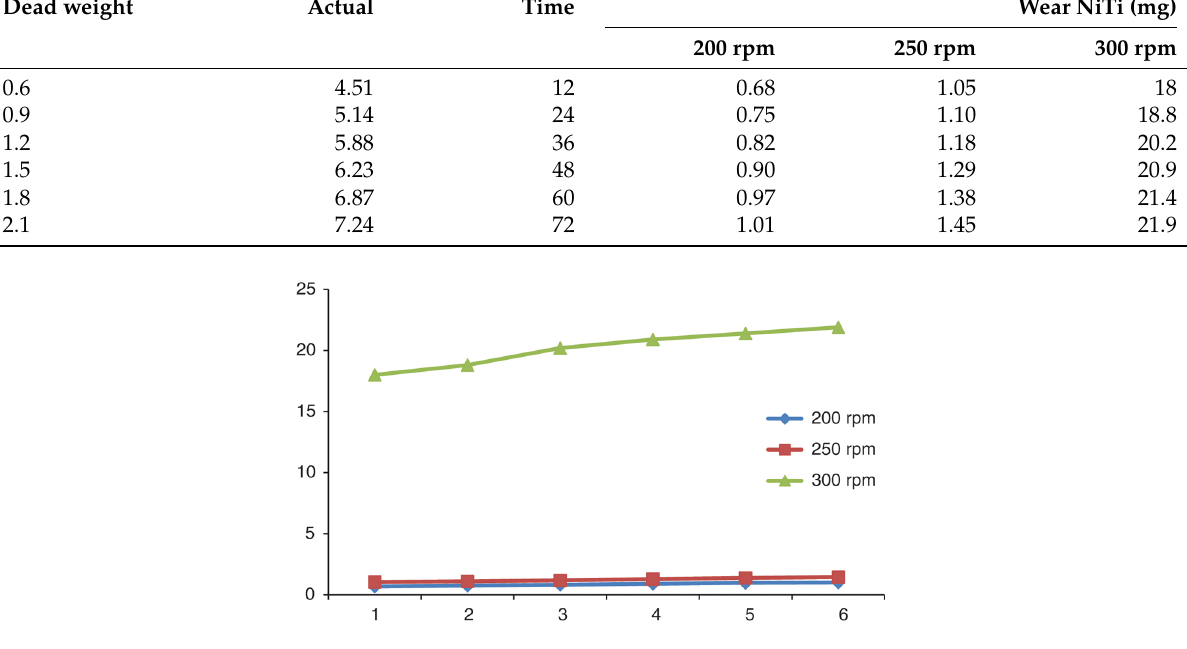
Figure 5: Wear behavior of NiTi